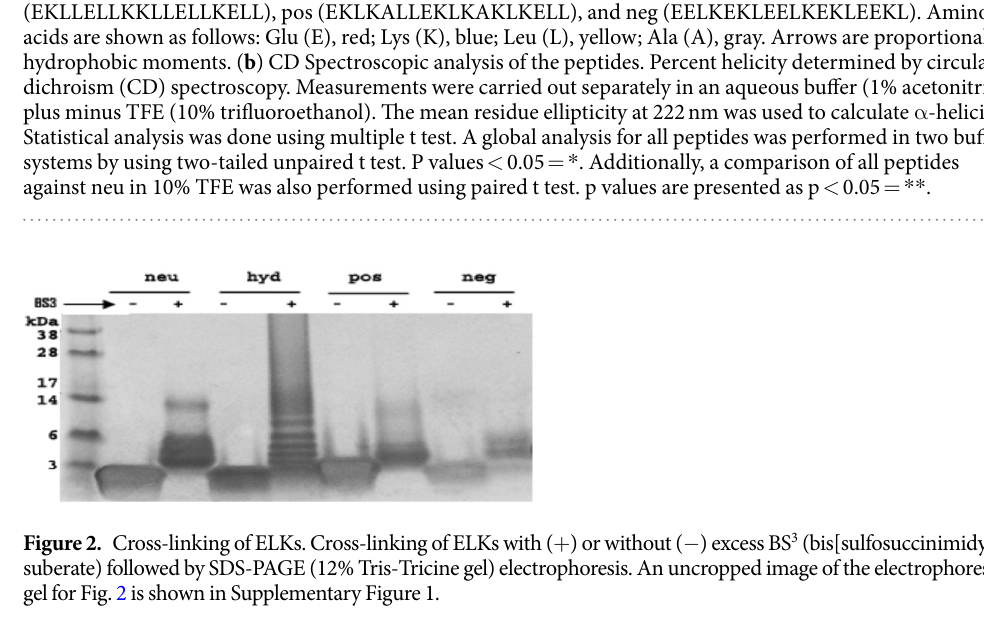
ABCA1. Again, both neu and hyd form HDL size particles but the particles produced by hyd are considera- bly larger. Pos also forms particles about 12 nm in diameter, but again no particles are observed with neg. The particle size formed by neu was further investigated using Transmission Electron Microscopy (TEM), using